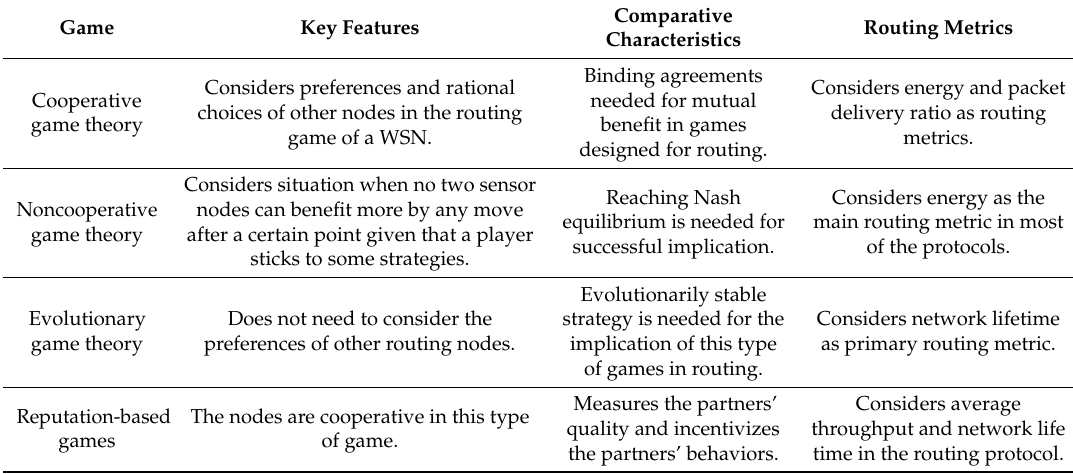
Table 3. Comparison of four kinds of games used in routing for wireless sensor networks